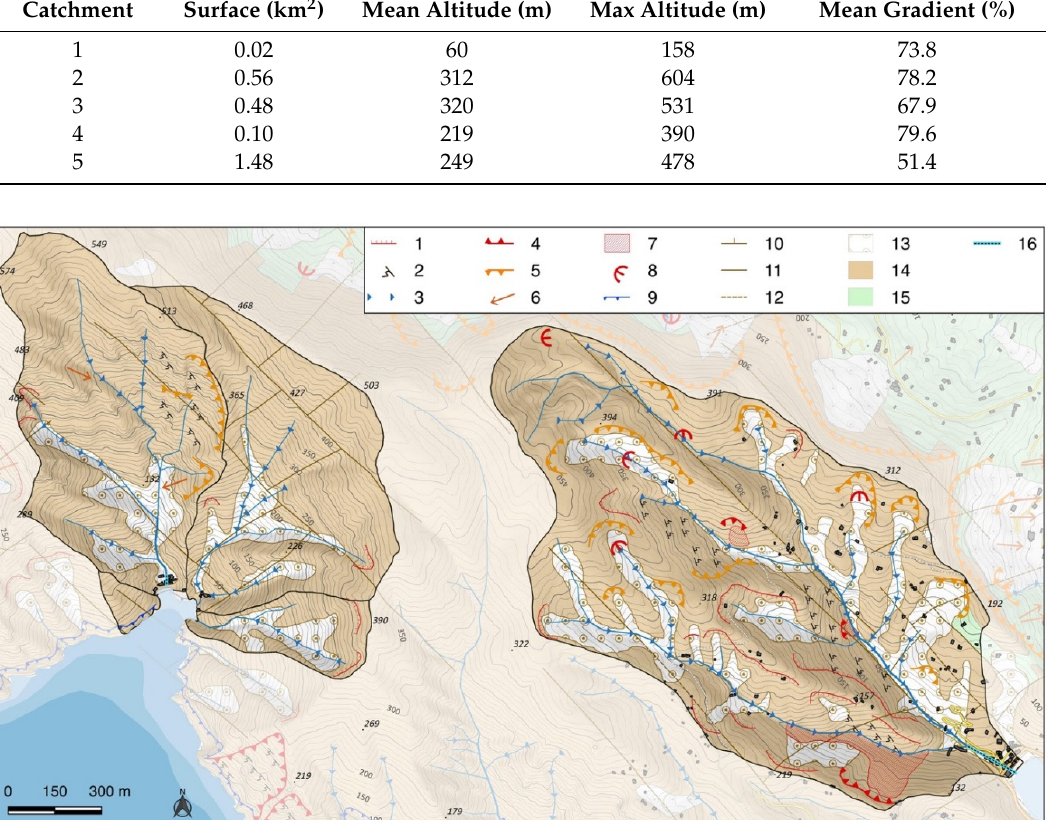
Table 1. Main morphometric features of the five studied catchments (see Figure 2B for location).